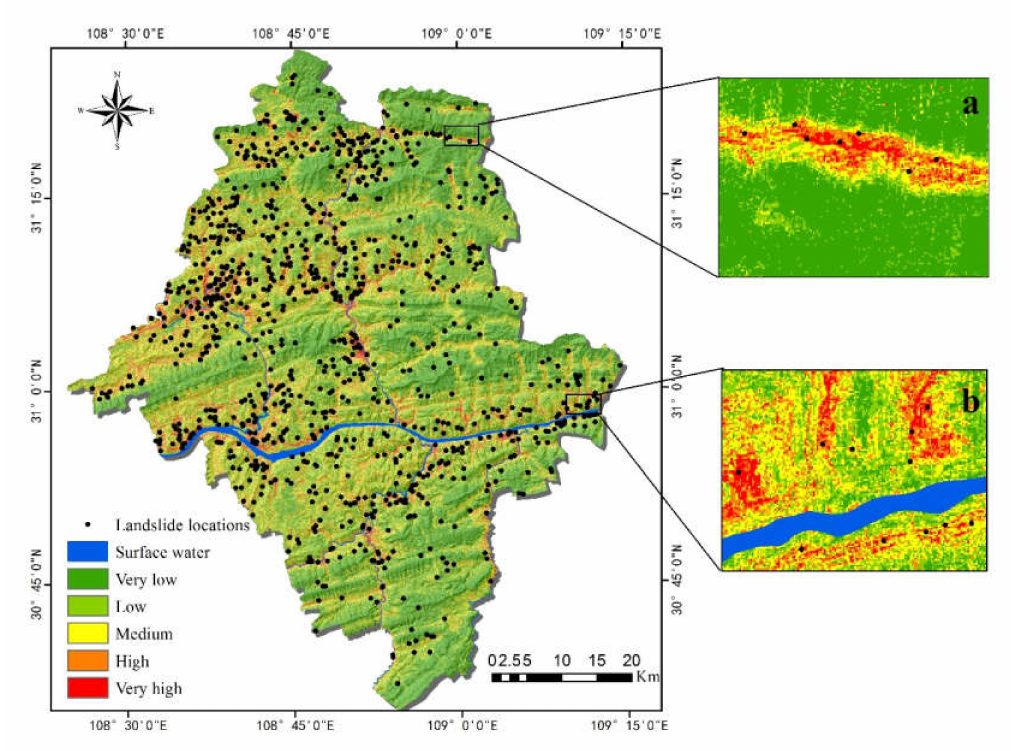
Figure 14. Landslide susceptibility map in the RF model: ( a ) Enlarged area of the valley; ( b ) Enlarged area along the